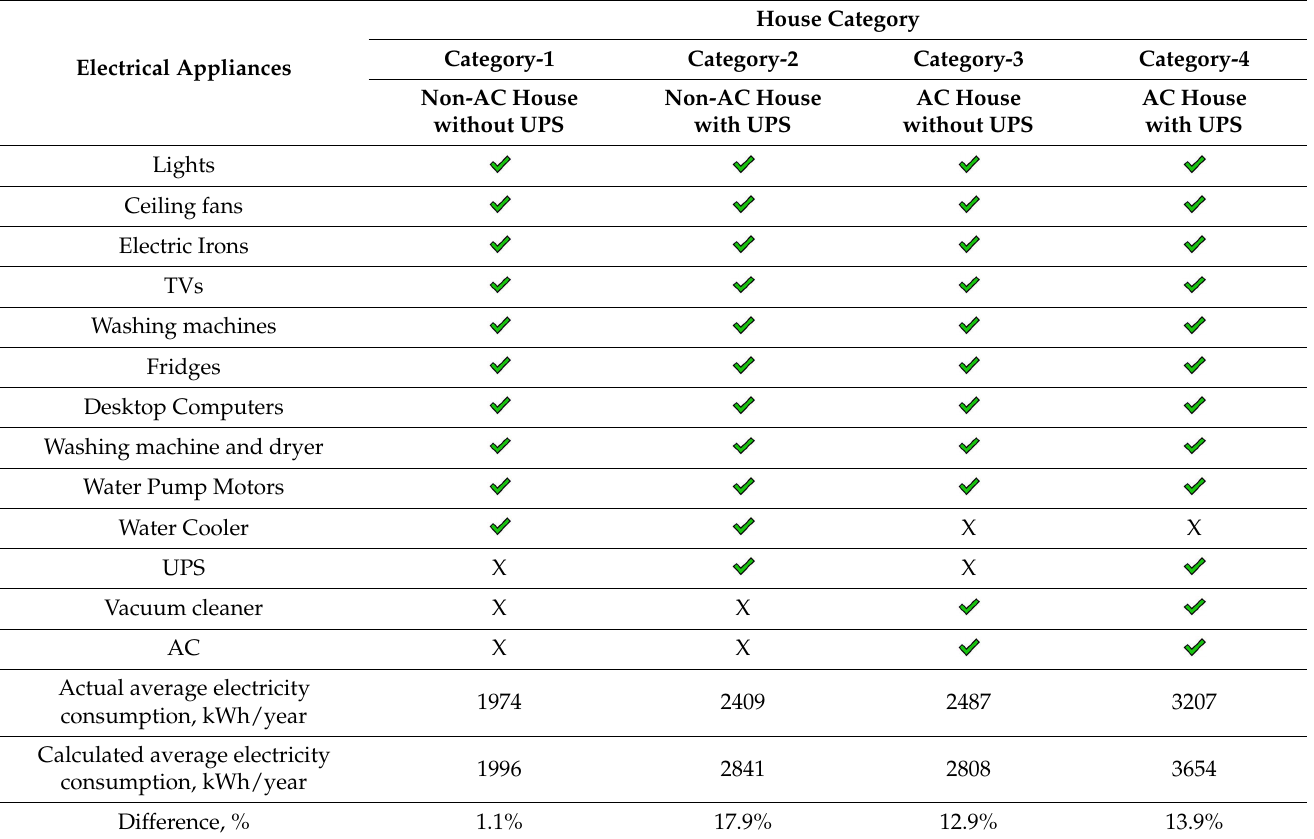
Table 7. Possession of electrical appliances in different house